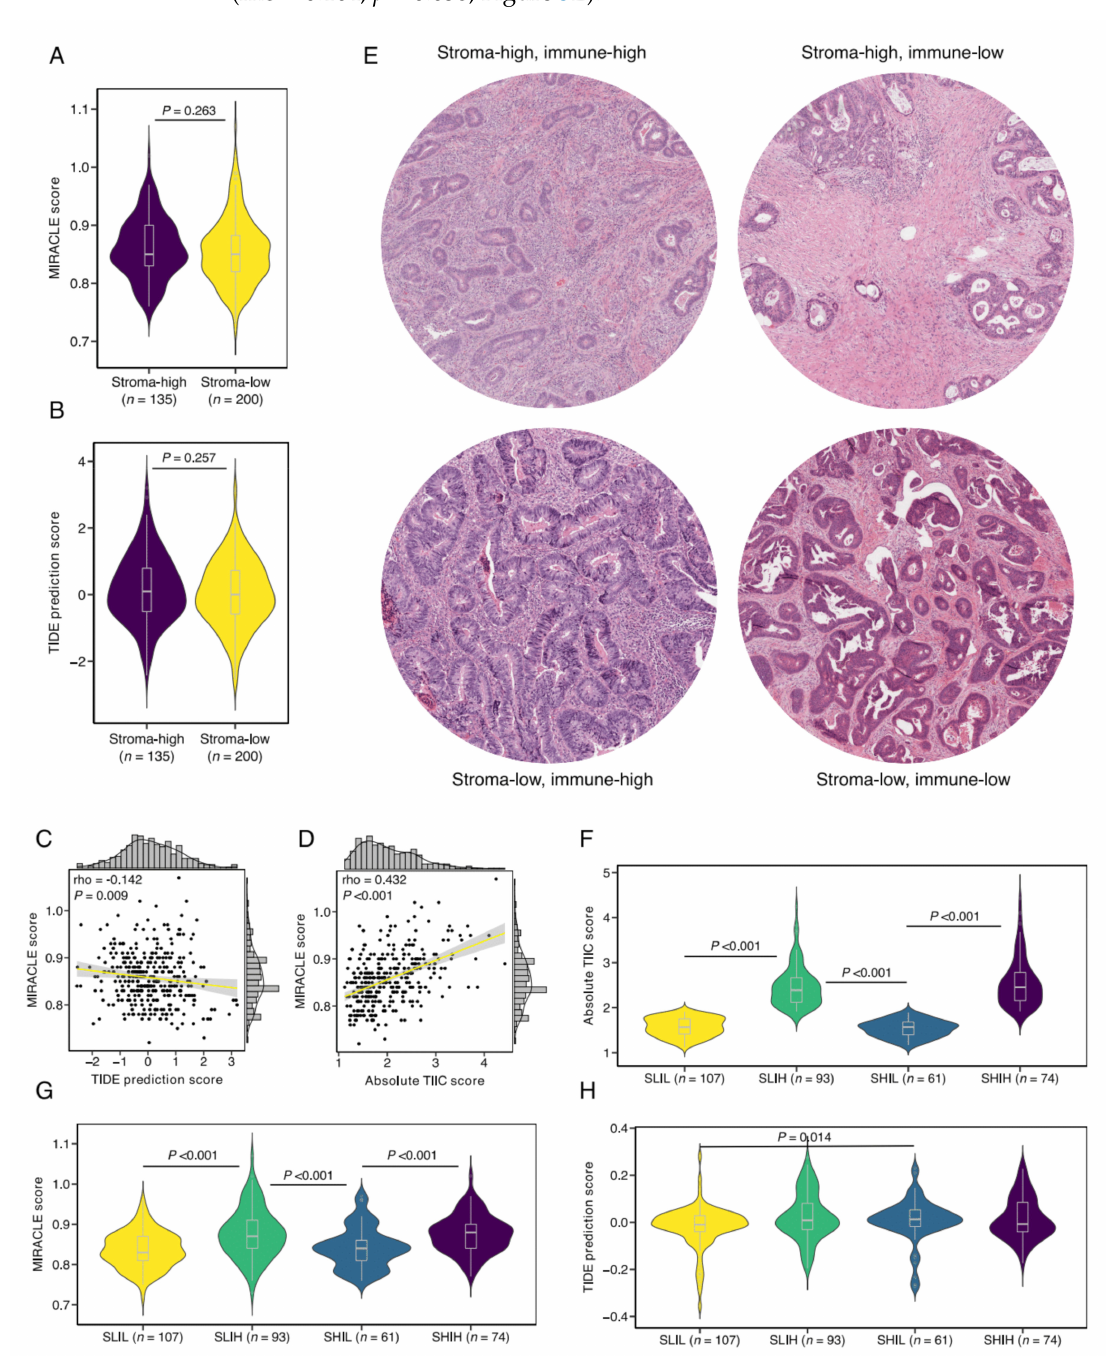
Figure 4. Defining stromal categories based on stromal content and immune cell infiltration. ( A ) MIRACLE scores in stroma-high and stroma-low tumors. ( B ) TIDE prediction scores in stroma-high and stroma-low tumors. ( C ) Correlation plot of MIRACLE and TIDE prediction scores. ( D ) Correlation plot of MIRACLE scores and total tumor-infiltrating immune cells (TIICs). ( E ) Representative illustrations of newly defined stromal categories based on stromal content and total TIICs. ( F ) The stromal categories and total TIICs. ( G ) The stromal categories and MIRACLE scores. ( H ) The stromal categories and TIDE prediction scores. Rho, Spearman’s rho; SLIL, stroma-low/immune-low; SLIH, stroma-low/immune-high; SHIL, stroma-high/immune-low; SHIH,